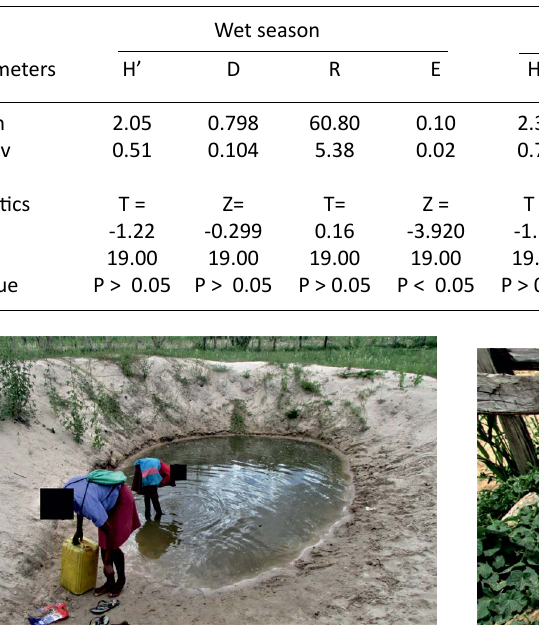
Fig. 1. A picture of type 1 shallow hand-dug wells found in the Ohangwena and Omusati regions of the CEB in which animals can walk into the water.